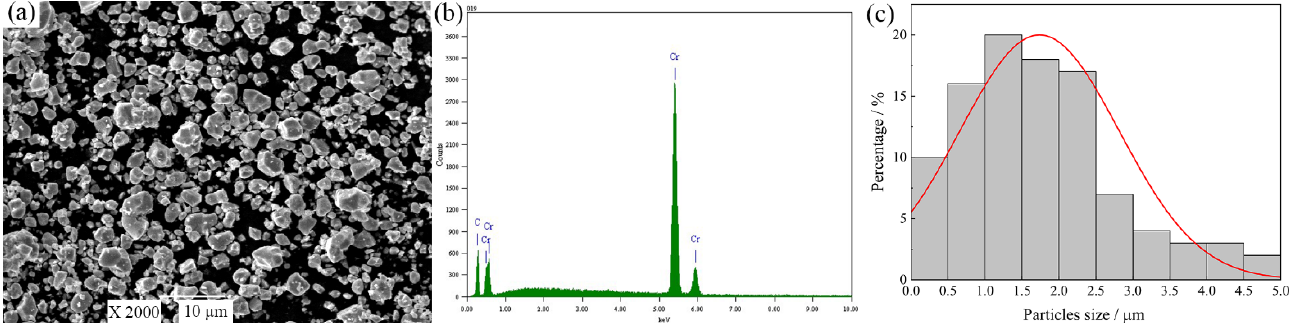
Figure 1. SEM figure, EDS result and particle size distribution of the initial Cr 3 C 2 powder: ( a ) SEM figure, ( b ) EDS result, and ( c ) particle size distribution.